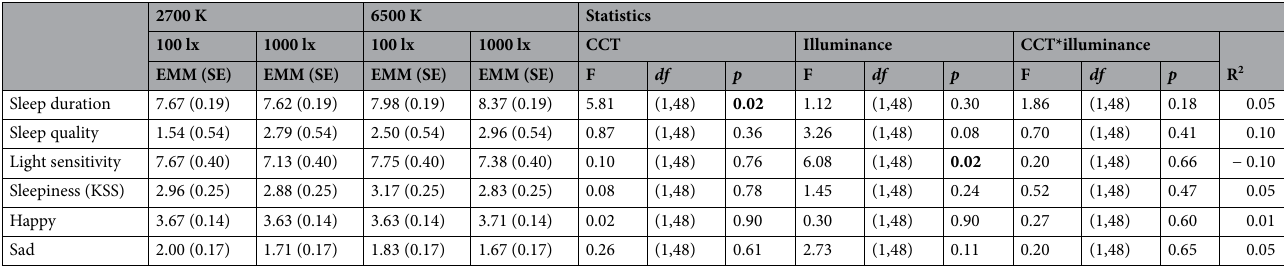
light was turned on, in which participants were free to read books containing no emotion priming contexts. Afterward, two computerized tasks were programmed with counterbalanced orders, and the order of the task assessed. A schematic representation of one full experimental session is depicted in Fig. 2D.